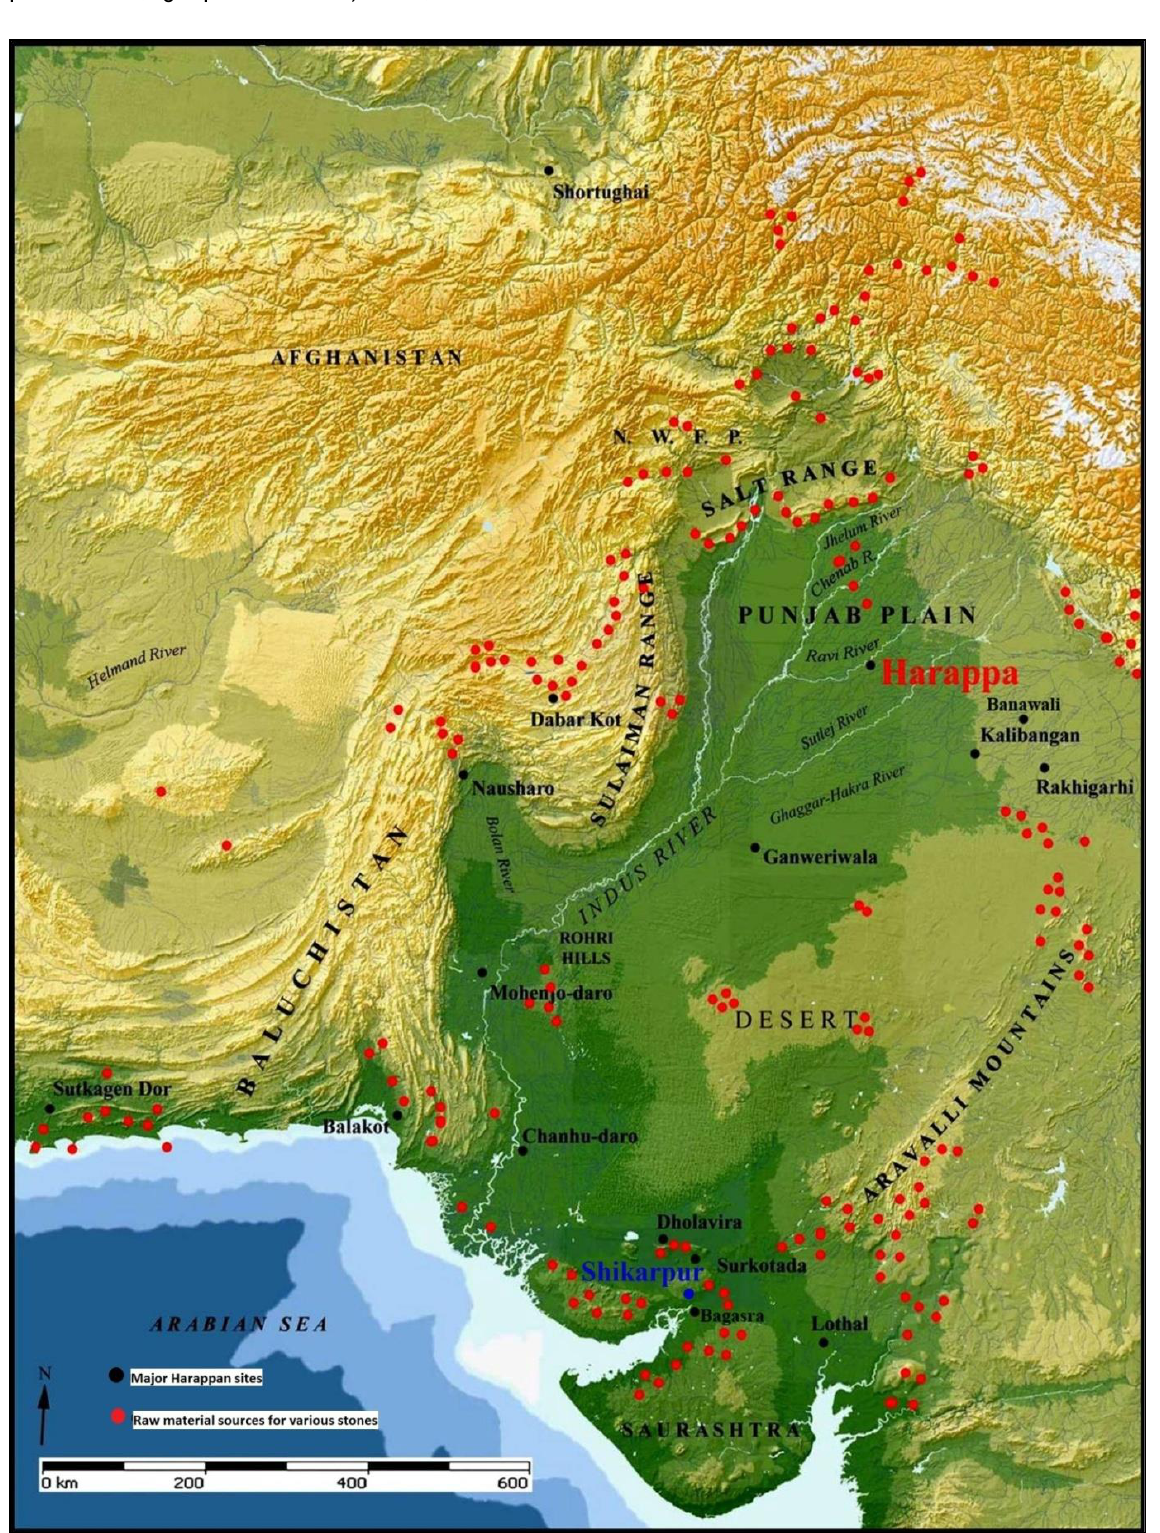
Figure 1. The Rohri hills along with major excavated sites of Harappan civilization. (Image courtesy: Randall